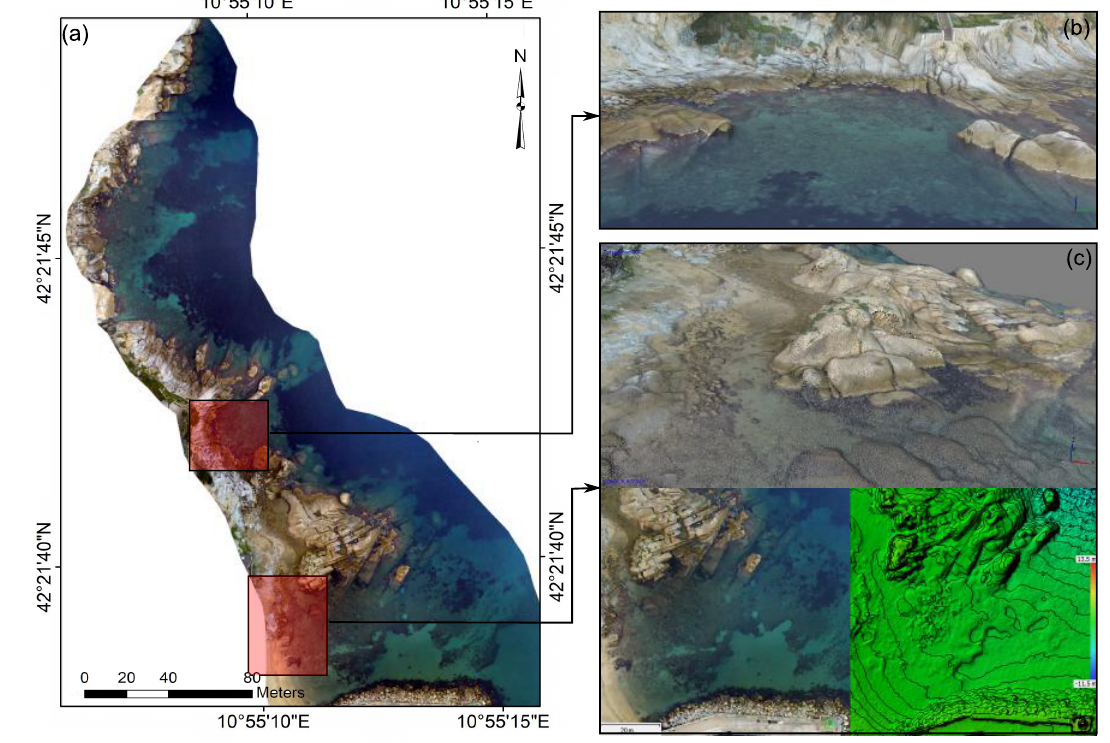
Figure 7. The orthomosaic generated by 160 overlapping images representing the rocky coastline of the S2 site ( a ). Red frames highlight the two small coves were the presence of particular natural features such as sandy patches, pebbles and large boulders made these areas suitable for settlement of juvenile sparid fish. The generated 3D outputs from structure from motion (SfM) routine: The 3D model ( b ) and digital elevation model ( c ) demonstrate the detail level to which coastal features are resolved in these products. Note that the elevation reported are affected by the effect of light breaking at the water/air